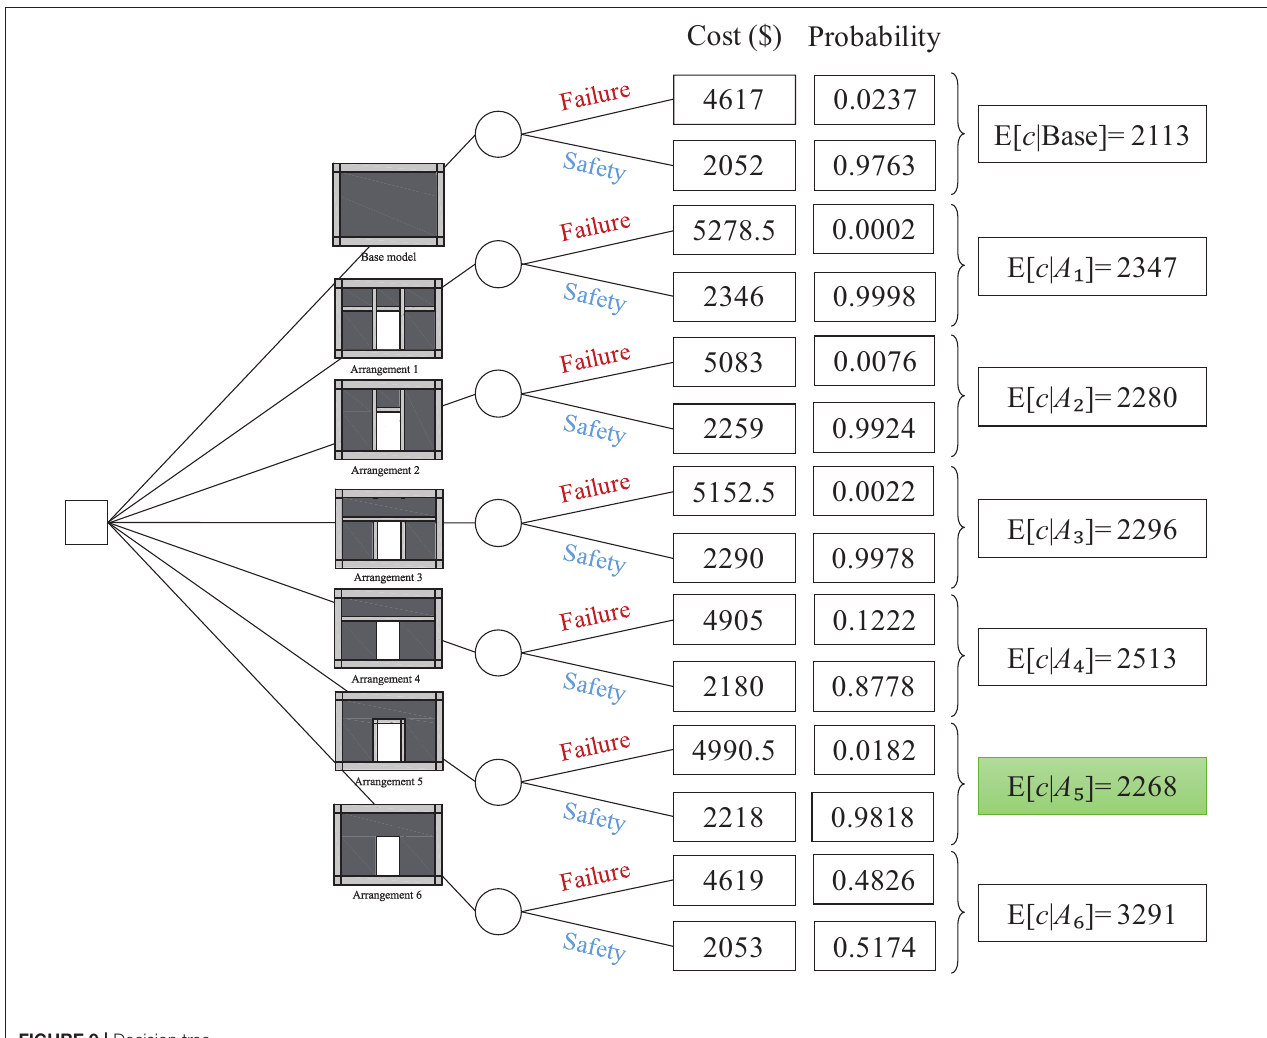
TABLE 4 | Decision analysis results based on expected utility theory.